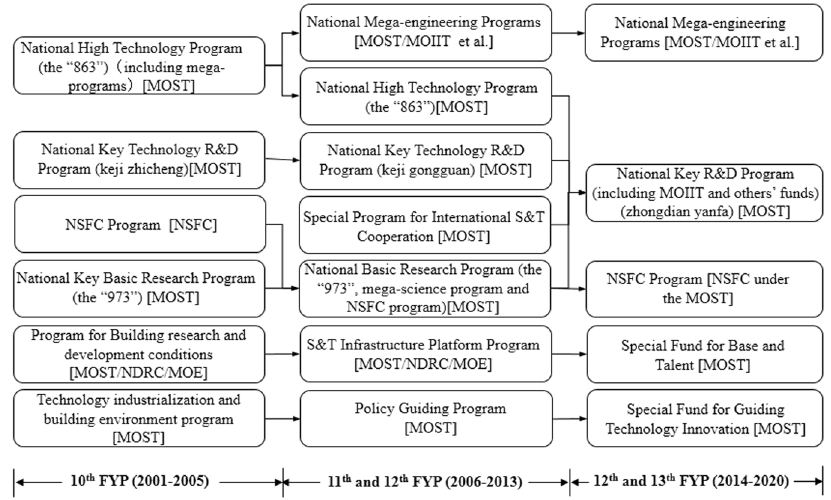
Fig. 2 China ’ s Reform for National S&T Programs between 2006 and 2020. Each panel provides the names of programs and the main government agencies in charge of the programs. MOST - Ministry of Science and Technology; NSFC - National Natural Science Foundation of China; NDRC -